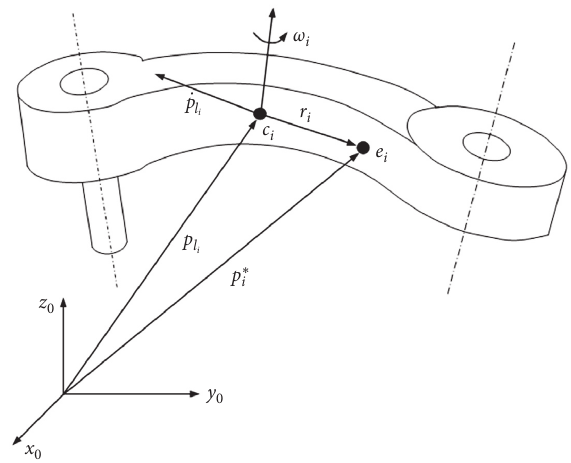
Figure 1: Kinematic description of the i th